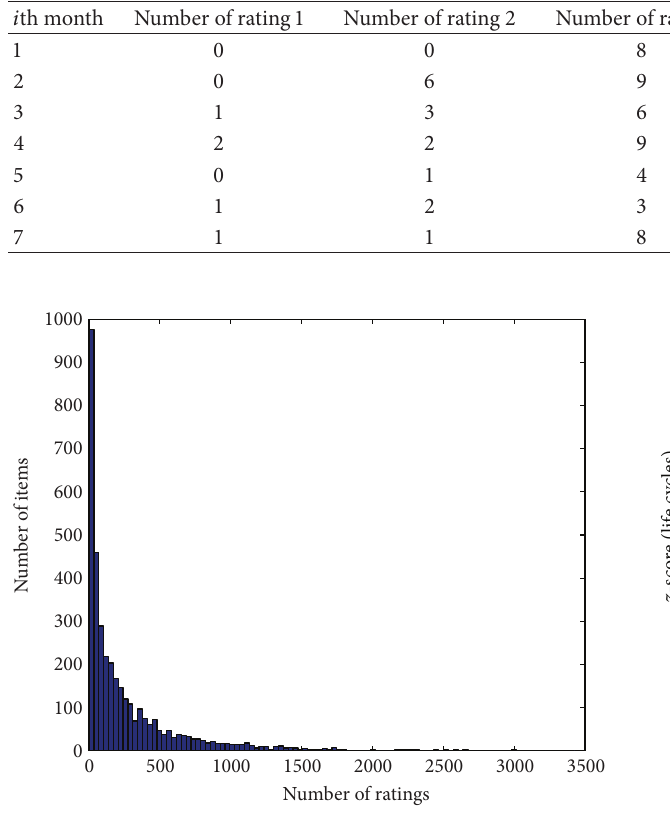
Figure 2: The relationship between the number of ratings and life